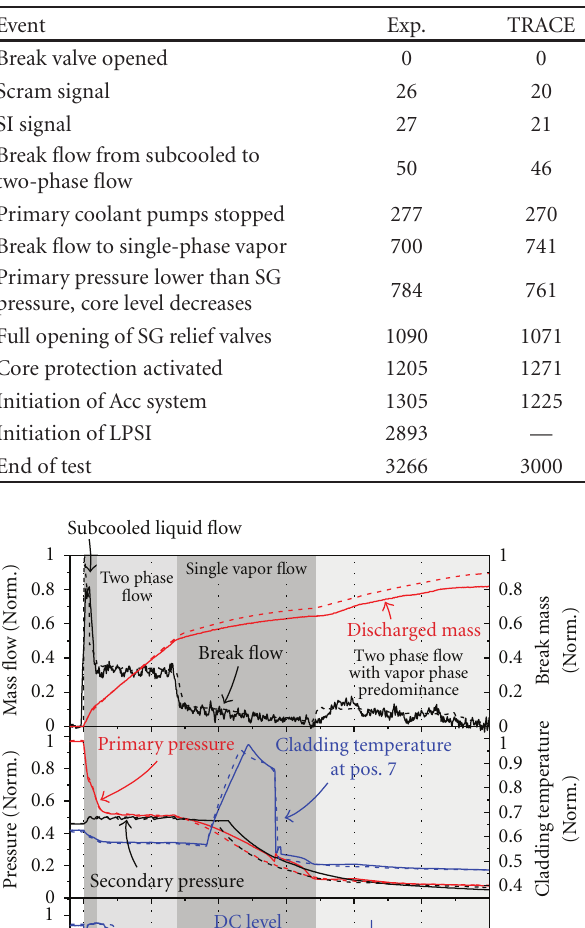
Table 3: Chronology of the main events in Test 6-1 [7].